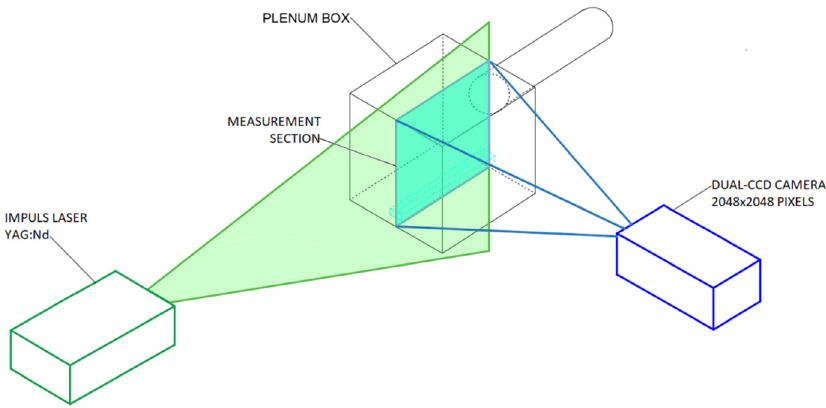
Figure 2. Diagram of the measurement section used for the measurements.